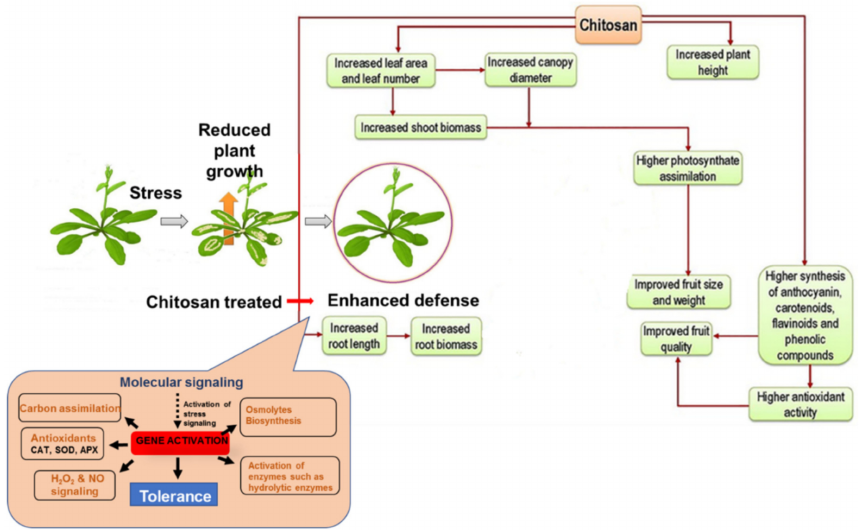
Figure 27. Plant growth conditions under the influence of chitosan